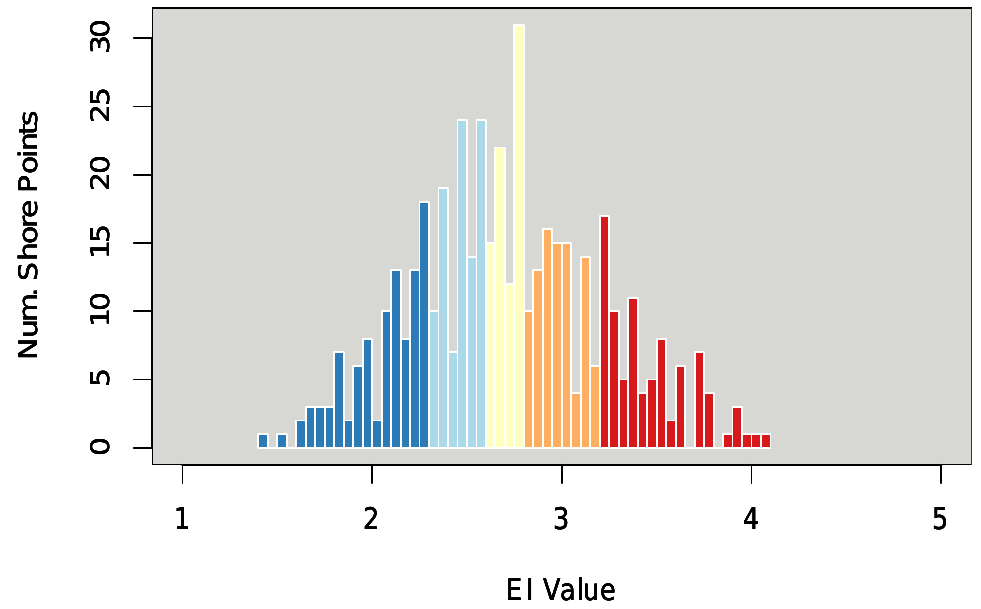
Figure 5. Distribution of the Exposure Index (EI). The plot is styled based on the 5 quantiles containing 20% of the distribution of the EI each. The colours are the same used in the maps presented in Figures 3 and